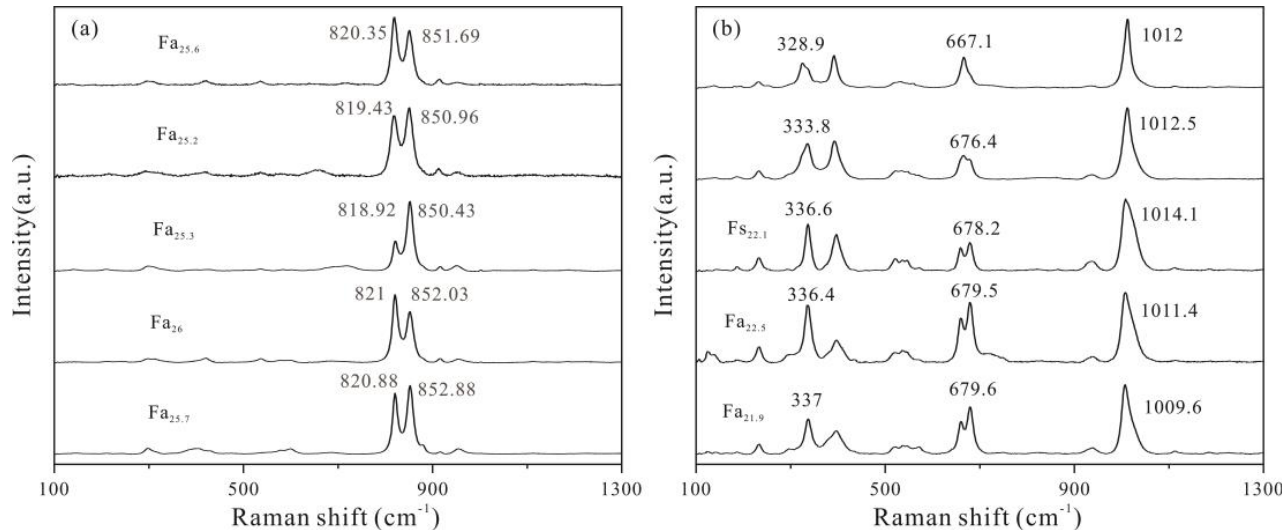
Figure 2. Raman spectra of olivine and pyroxene in GRV 090360. ( a ) is olivine in GRV 090360. ( b ) is pyroxene in GRV 090360.